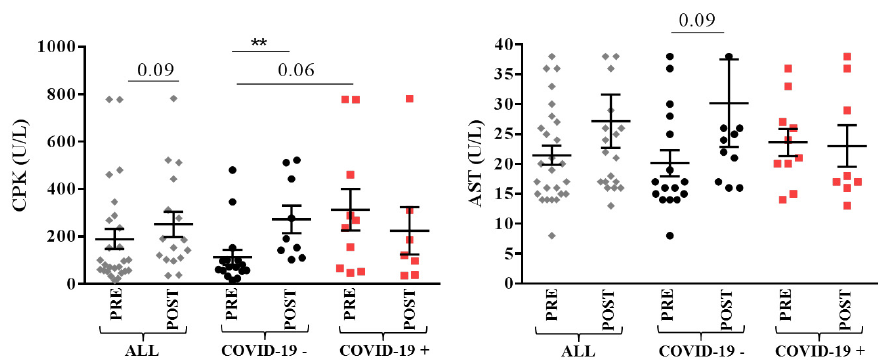
Figure 3. Muscular markers in overall (ALL, grey), COVID-19 − (black) and COVID-19 + (red) patients with lower limbs fractures registered pre- (PRE) and day 1–5 (POST) post-surgery. Mean with SEM are showed.** p < 0.01.